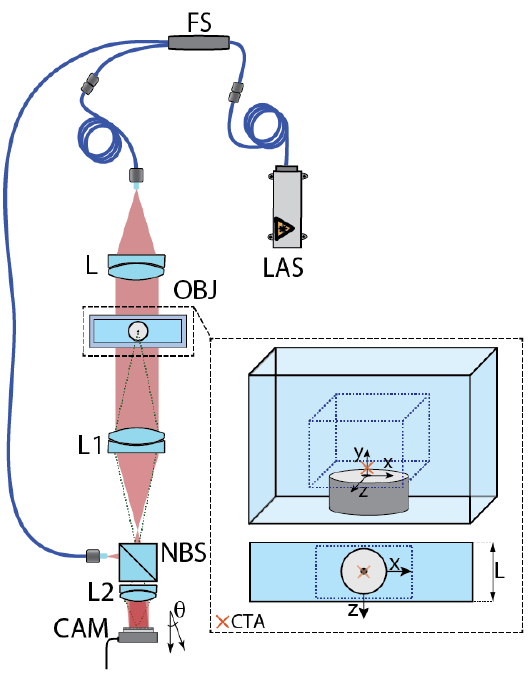
Figure 2. Schematic of the Mach-Zehnder optical setup. The used camera is a UI-3370CP Rev. 2, 2048 × 2048 pixel, 5.50 μm pixel size CMOS camera.